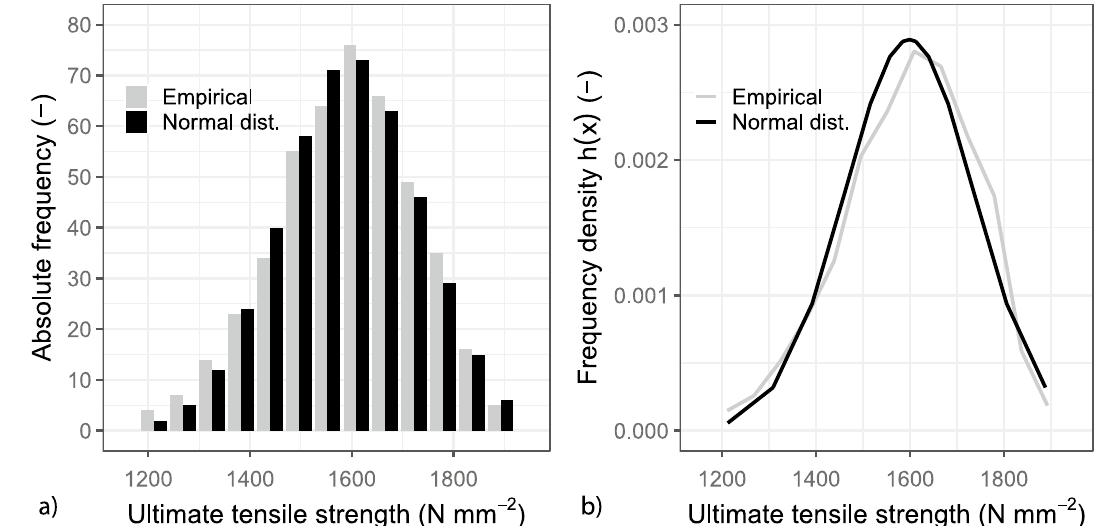
Figure 4. Statistical evaluation of the ultimate tensile strength 15 ( a ) Histogram for the AR-Glass reinforcement (empirical and theoretical values). ( b ) Probability density function of the AR- Glass